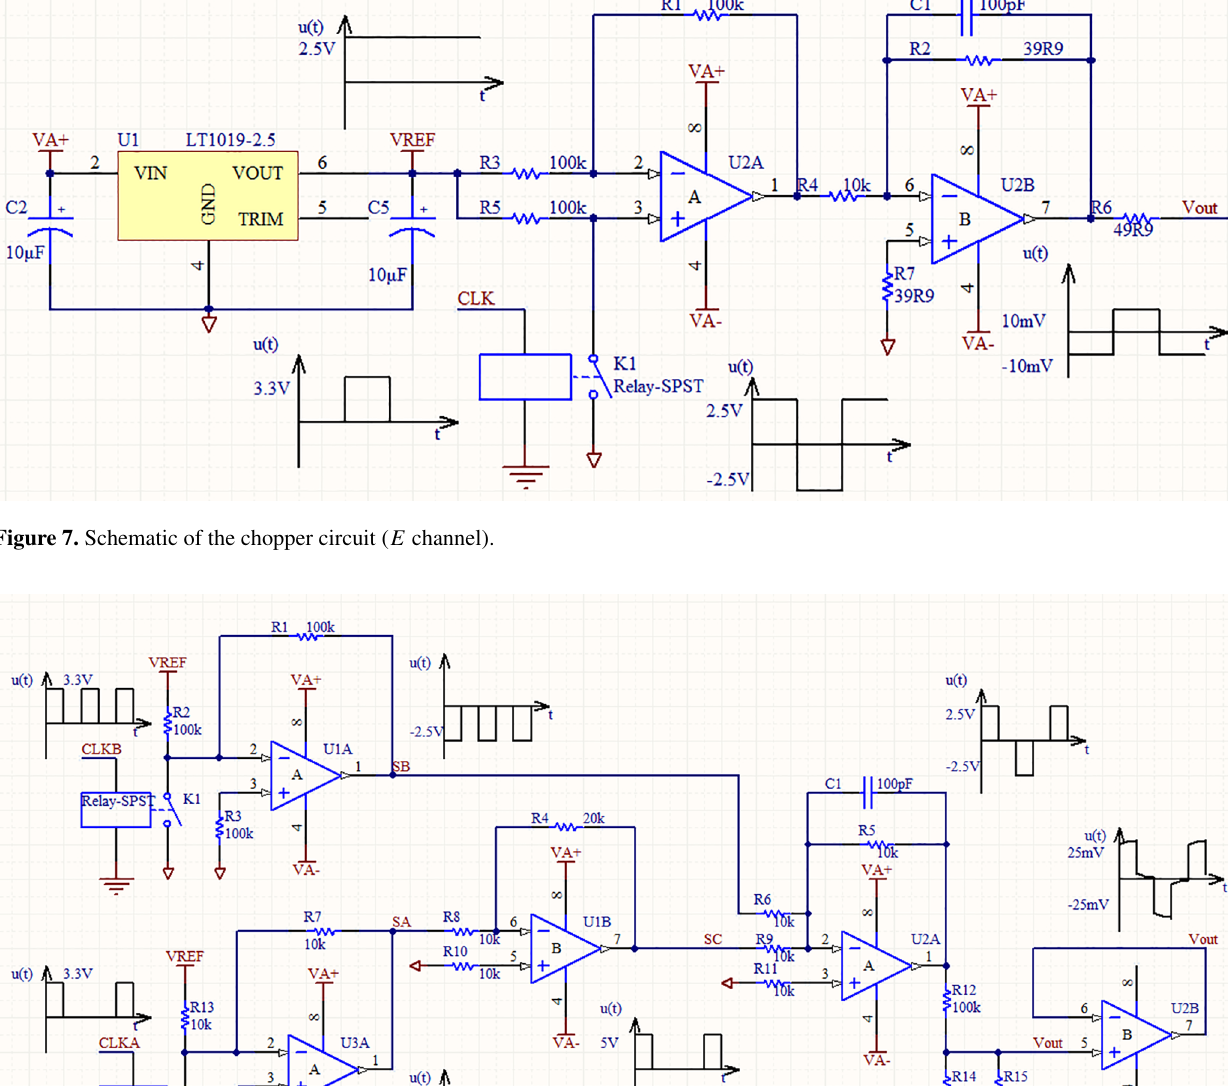
ature range of − 20 to 75 ◦ C. The power consumption of the module is 12 mA at 3.3 V. For example, to generate the clock ( f = 9600 Hz) in the CSAMT mode, the MCU sets the divi- sion factor to 1280 and the CPLD divides the clock signal, which is triggered by the PPS from the GPS module. After 50 PPS counts, the MCU sets the division factor to 1600, and the output clock frequency changes to 7680 Hz. The above steps are then repeated, and each division is triggered by the PPS. There is a 1 s pause between each switch divider for